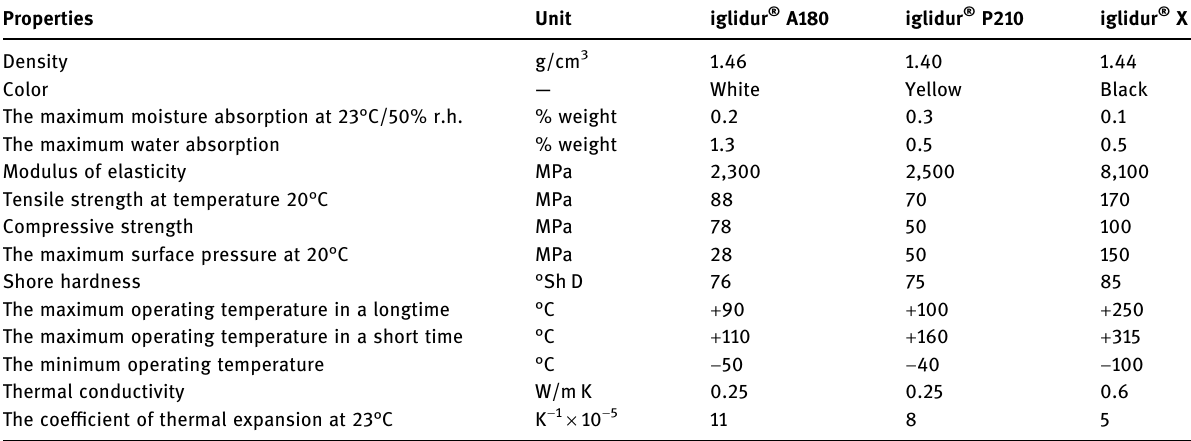
Table 1: Summary of physical and mechanical properties of the researched polymer materials [ 37 ]